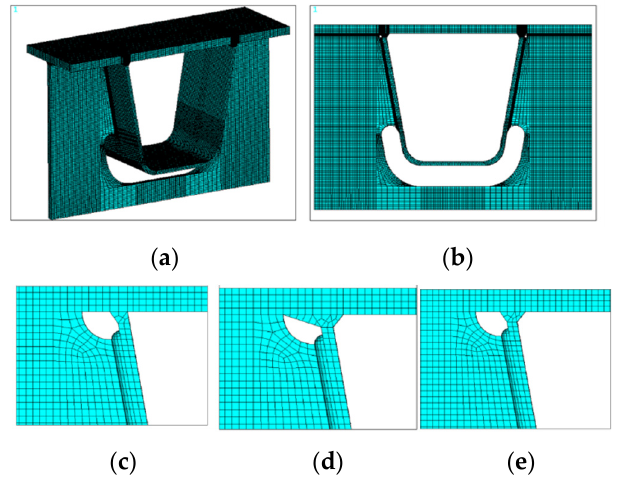
Figure7. ThefinitemodeloftheOSBDandtypicalconnections. ( a )theoverallmodelofOSB;( b )thefinite element model of OSB; ( c ) conventional weld seam; ( d ) weld seam of large root; ( e ) double-sided